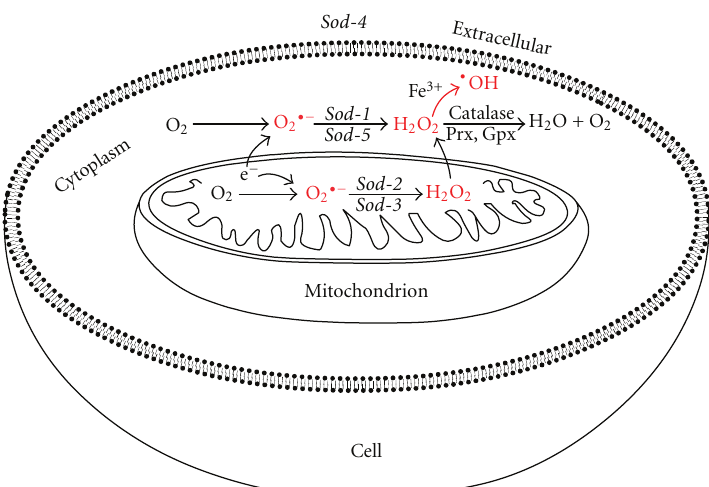
Figure 1: Simplified pathways of ROS production and antioxidant detoxification in a C. elegans cell. ROS molecules superoxide (O 2 •− ), hydrogen peroxide (H 2 O 2 ), and hydroxyl radical ( • OH) are depicted in red. Antioxidants convert ROS to less reactive molecules. The five di ff erent superoxide dismutase enzymes convert superoxide to H 2 O 2 and are depicted in their respective cellular compartments. Catalase, peroxiredoxin (Prx), and glutathione peroxidase (Gpx) convert H 2 O 2 to H 2 O and O 2 . Rapid detoxification of H 2 O 2 is necessary as it can become oxidised to form the potent free-radical • OH. ROS can be damaging to DNA, RNA, proteins, and lipids, and high ROS levels can cause oxidative stress. Some antioxidant genes, such as catalase and sod-3, can be upregulated in response to oxidative